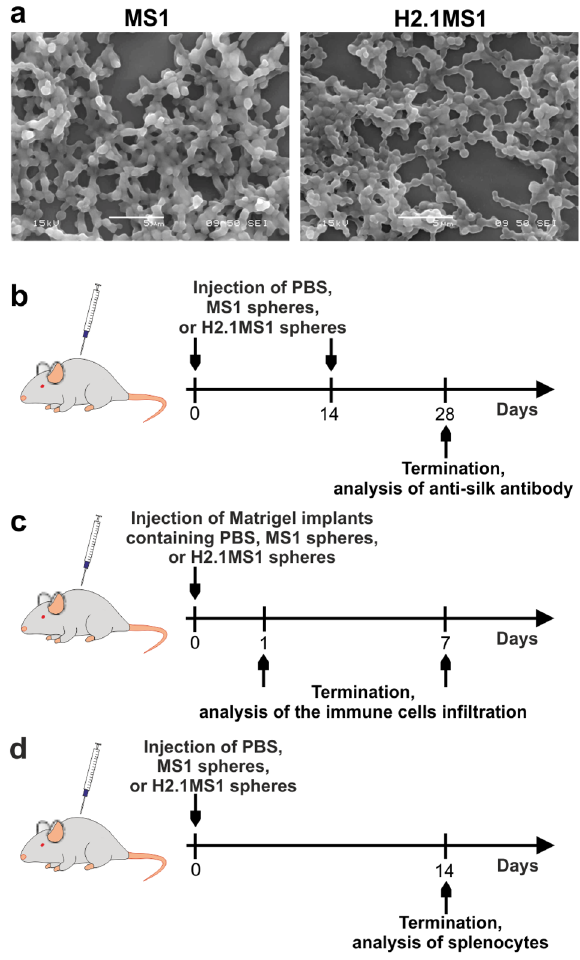
Figure 1. Morphology of the MS1 and H2.1MS1 spheres and a schematic representation of experiments. ( a ) SEM micrographs of the MS1 and H2.1MS1 spheres at 5000 × magnification (scale bar = 5 µm). A schematic representation of experiment for analysis of ( b ) antibody production in response to silk spheres, ( c ) immune cells infiltration at the site of silk sphere administration, and ( d ) phenotype and activity of splenocytes after silk spheres administration.